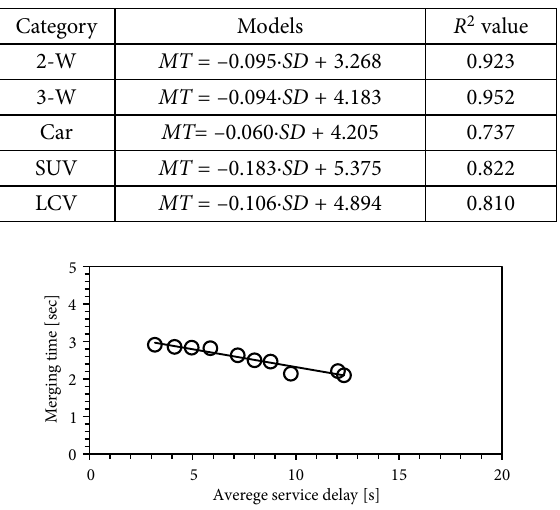
Table 6. Proposed models for MT for different